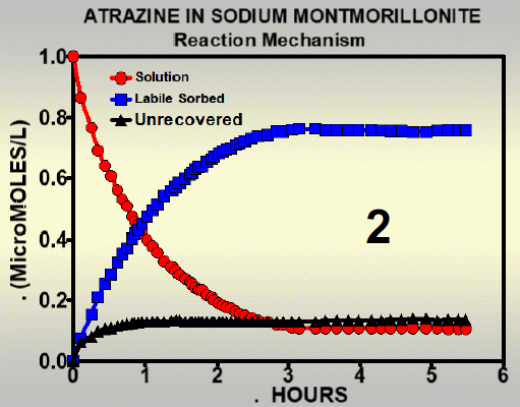
Figure 2. Atrazine in a suspension of sodium montmorillonite 25.0 °C. Kinetics curves for sorption and chemical reaction, produced by the subtraction indicated in Figure 1.